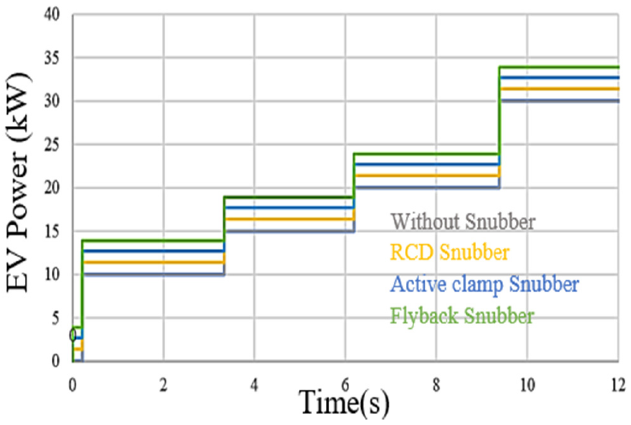
Figure 9. Power response curve of EVs.